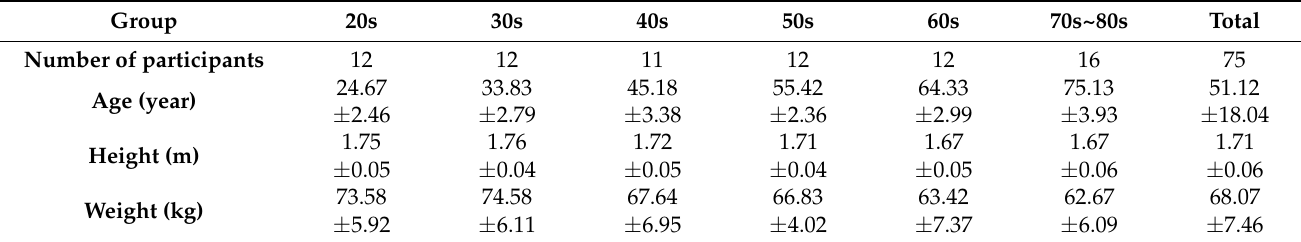
Table 1. Subject characteristics for each age group.